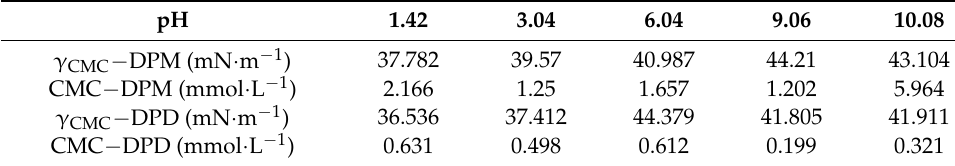
Figure 3. γ−logc curves of DPM ( a ) and DPD ( b ) at different pH values. γ CMC and CMCs of DPM and DPD at different pH Table 2. γ CMC and CMCs of DPM and DPD at different pH values. Table 2.